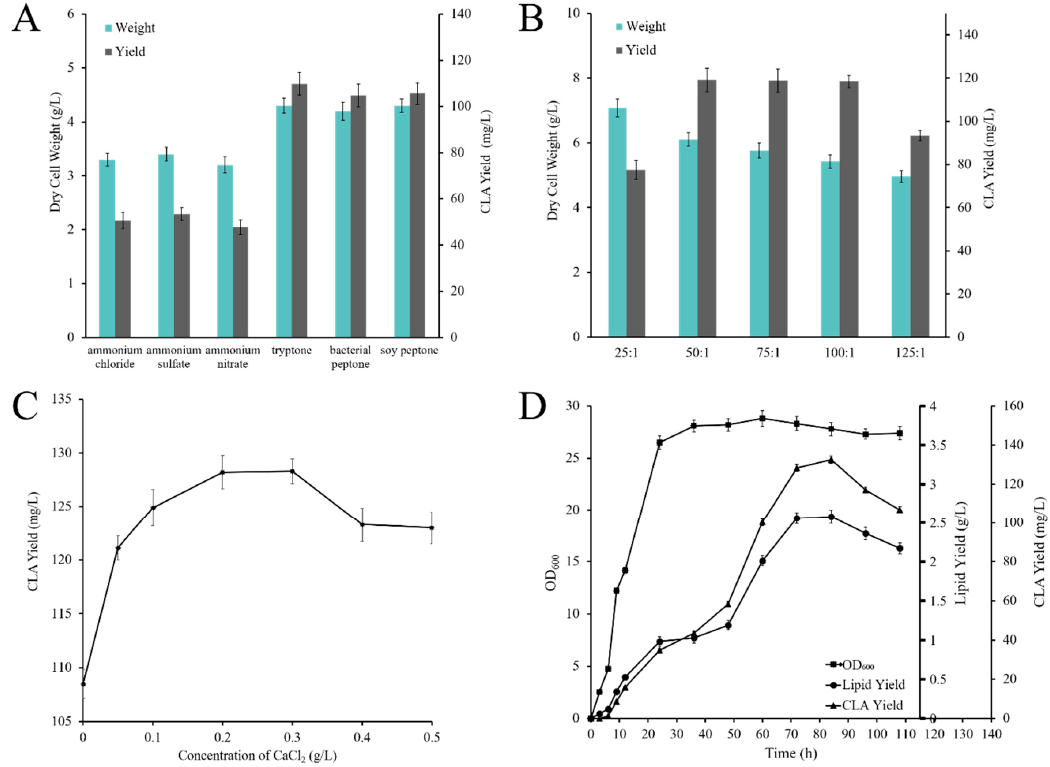
Figure 5. Effects of different culture conditions on Y. lipolytica . ( A , B ) Effects of different nitrogen sources and C/N ratios on CLA production. ( C ) The Y. lipolytica was cultured at different inorganic salt concentrations: Ca 2+ . ( D ) Under optimal conditions, the lipid and CLA production by recombinant strain WXYL037.